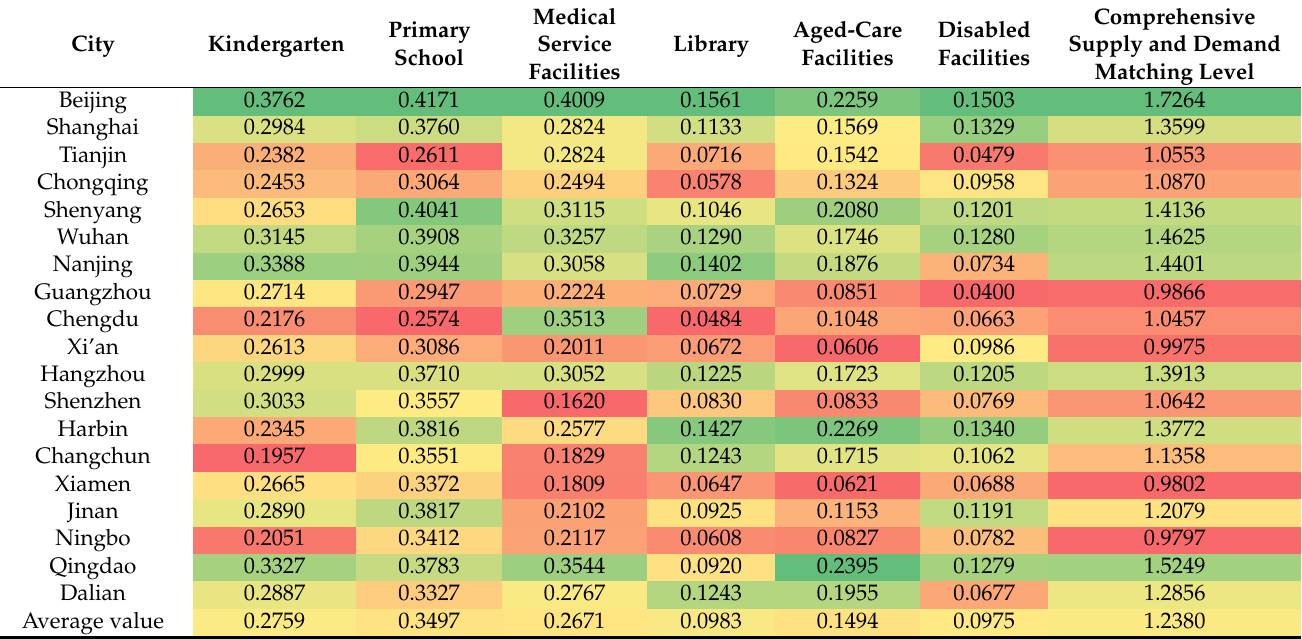
Table 2. Facility supply and demand matching level